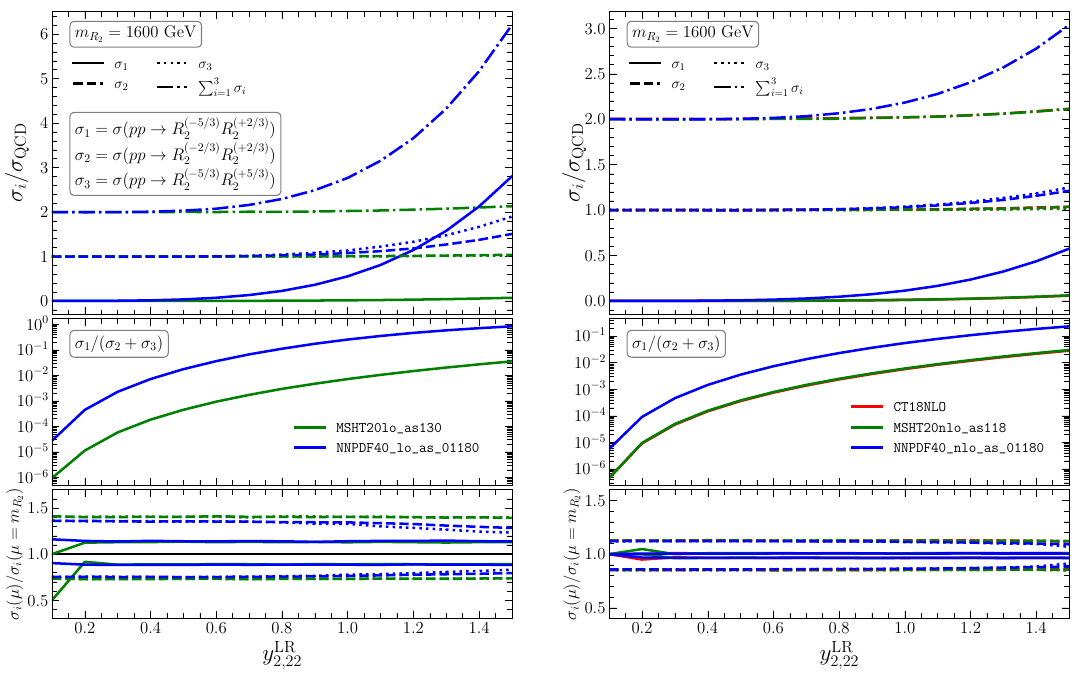
Figure 6 . Same as in figure 5 but for an R 2 leptoquarks scenario in which the only non-zero Yukawa coupling is y LR 2 , 22